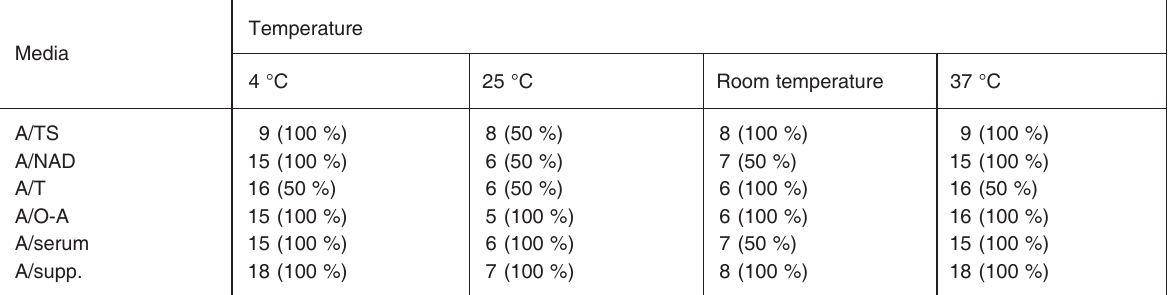
TABLE 4 Comparison of the maximum survival time in days of H. paragallinarum in the different transport media. The figure in brack- ets is the percentage of isolates surviving on the last day when growth was detected